Question: Identify the chart type used in this figure.
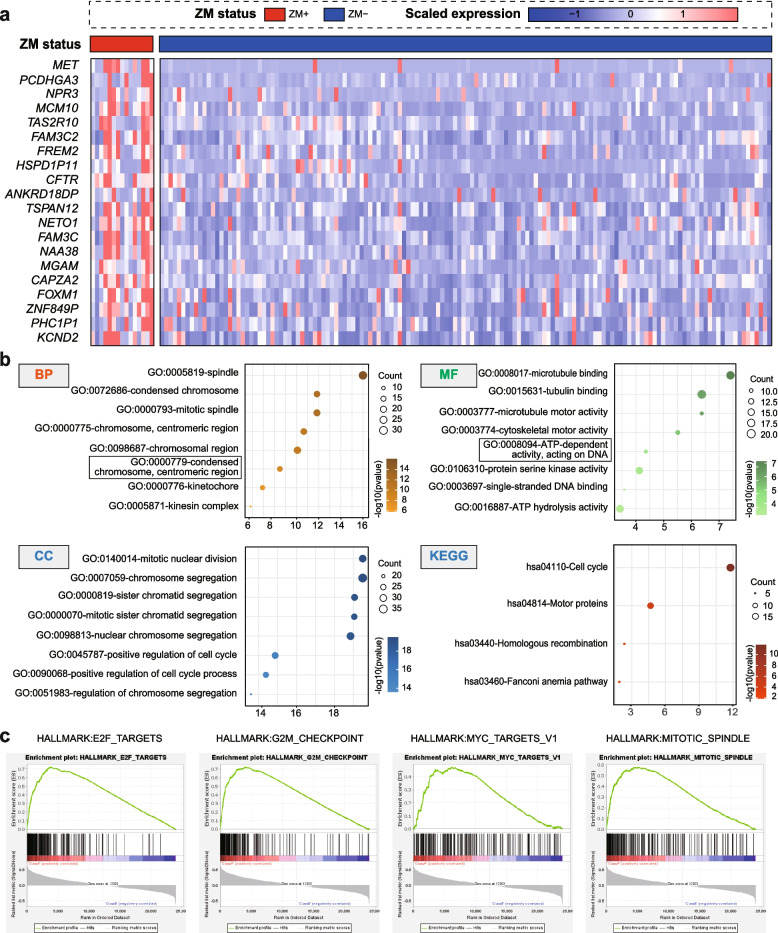
Answer: heatmap